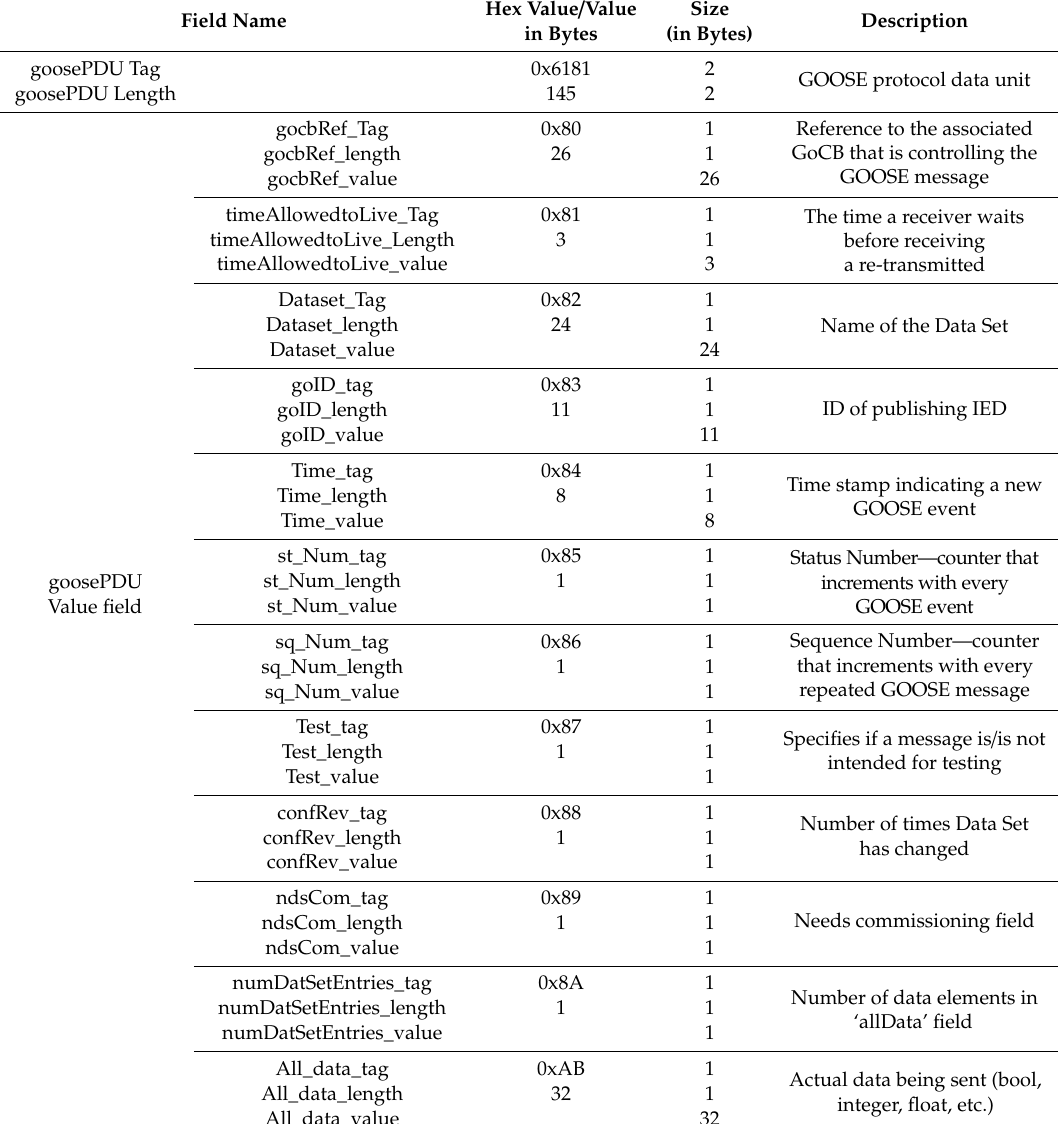
Table 1. GOOSE payload